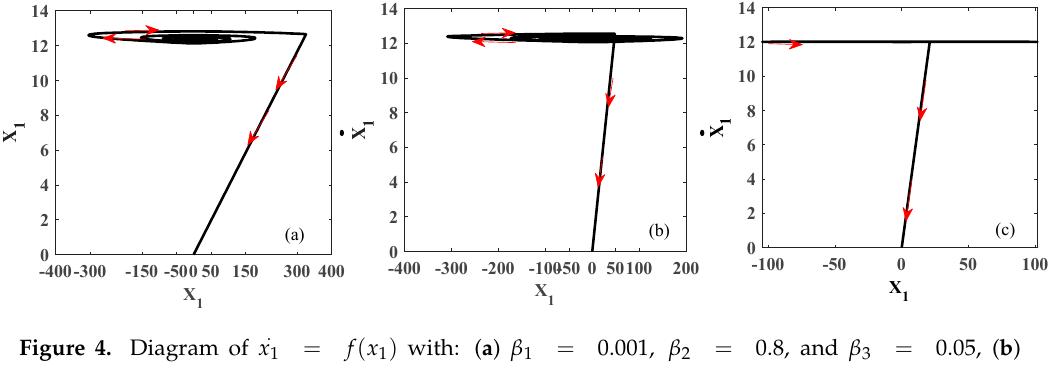
. x 1 = f ( x 1 ) with: ( a ) β 1 = 0.001, β 2 = 0.8, and β 3 = 0.05, ( b ) Figure 4. Diagram of Figure 4. Diagram of 𝑥 (cid:2869) (cid:4662) = 𝑓(𝑥 (cid:2869) ) with: ( a ) 𝛽 (cid:2869) = 0.001,𝛽 (cid:2870) = 0.8 , and 𝛽 (cid:2871) = 0.05 , ( b ) 𝛽 (cid:2869) = 0.01, 𝛽 (cid:2870) = β 1 = 0.01, β 2 = 0.8, and β 3 = 0.09, and ( c ) β 1 = 0.001, β 2 = 0.8, and β 3 = 5. 0.8 , and 𝛽 (cid:2871) = 0.09 , and ( c ) 𝛽 (cid:2869) = 0.001, 𝛽 (cid:2870) = 0.8 , and 𝛽 (cid:2871) = 5 .